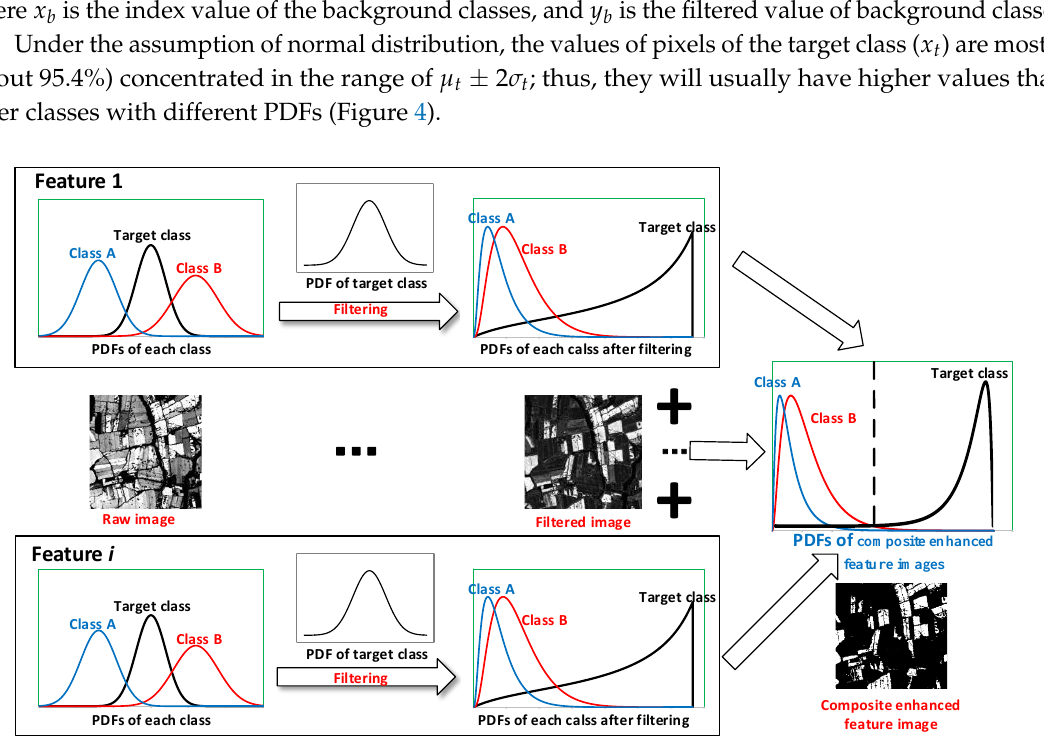
Figure 4. Illustration of feature filtering and enhancement based on probability density function (PDF).